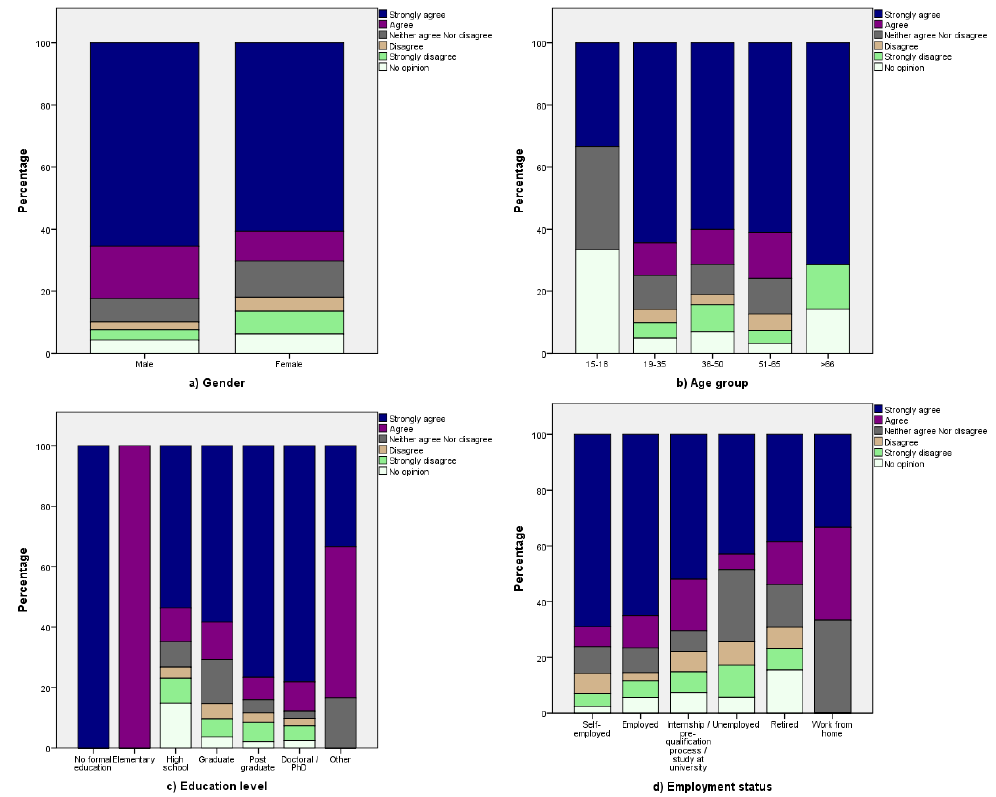
Figure 4. Opinion of participants on introducing EASPC as mix to the current walk-in method by a) Gender, b) Age Group, c) Education Level, and d) Employment